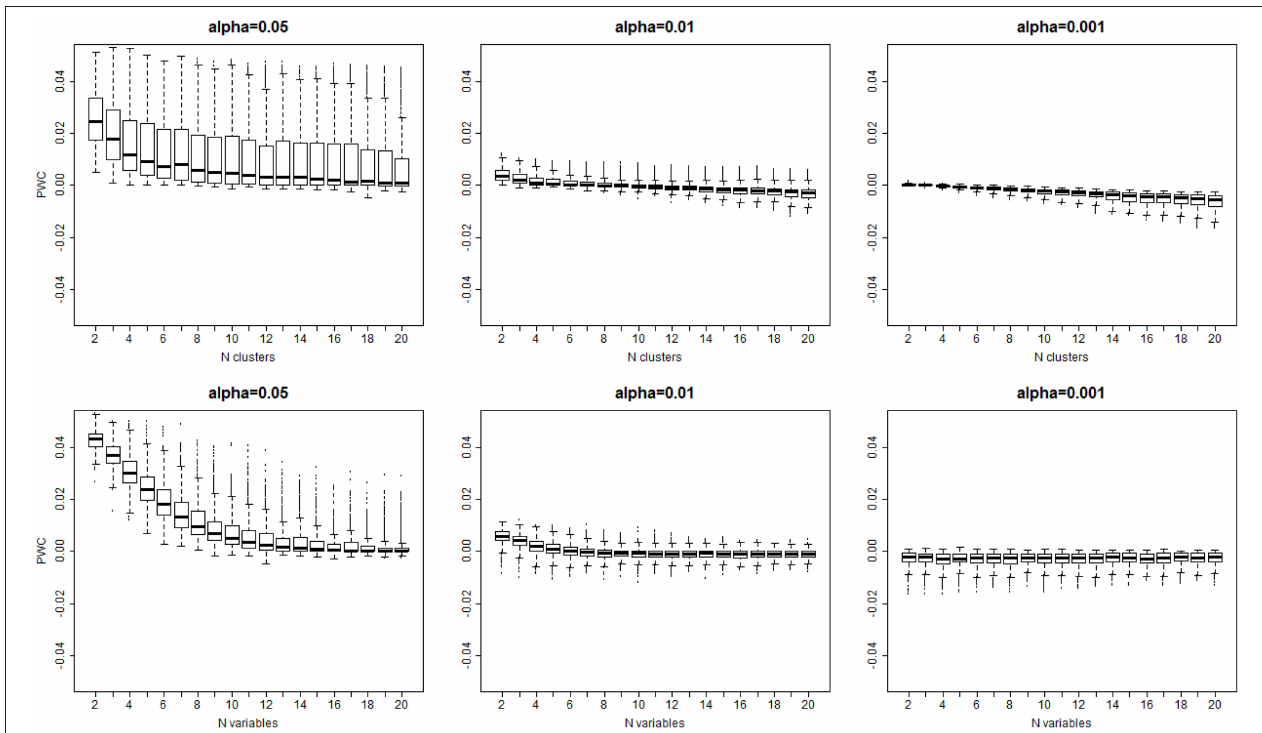
FIGURE 4 | Distribution of the error rate ( PCW = ( ˆ n cq − n c ) / ( n s − n c )) vs. the true number of clusters (top panel), and the true number of variables bottom panel) for different significance levels α = 0.05 , 0.01 , 0.001. The error rate decreases with larger number of variables and larger number of clusters that are both associated with larger separation of clusters (See Supplement Figure